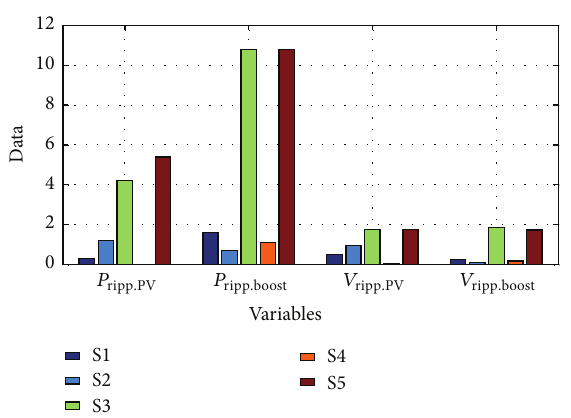
Figure 21: The bar graph for boost converter